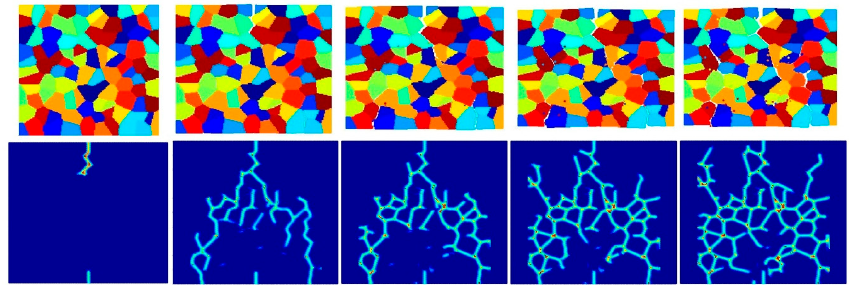
Figure 15. Fracture pattern of polycrystal when β = 0.5 with 150 × 150 particles. From left to right: time = 1.5 µ s, 2.0 µ s, 2.5 µ s, 3.0 µ s, and 3.5 µ s, respectively.